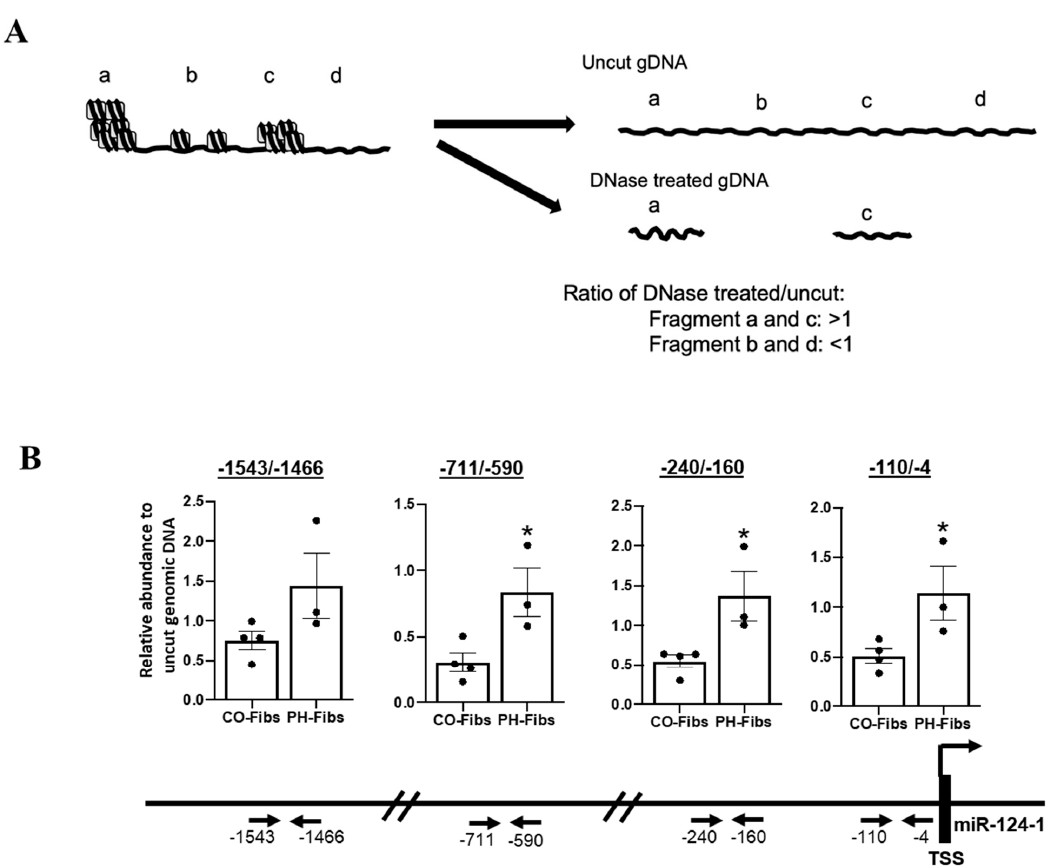
Figure 4. miR-124-1 gene in human PH-Fibs is more condensed (closed), compared to that in CO-Fibs, as assessed using DNase I sensitivity assay. ( A ) Schematic presentation of DNase I Sensitivity Assay. DNA in closed chromatin (a and c) is not accessible, thus resistant to DNase I digestion, so the ratios of these DNA in DNase treated genomic DNA pool versus in uncut genomic DNA pool will be close to 1 or above 1. However, DNA in more loosely packed chromatin (b and d) will be digested by DNase I, so the ratios of these DNA in DNase treated genomic DNA pool versus in uncut genomic DNA pool will be less than 1. ( B ) DNase I Sensitivity Assay was used to determine the chromatin structure of the miR-124-1 gene’s promoter (-110/-4), proximal promoter (-240/-160) and enhancers (-711/-590 and -1543/-1466) in CO- ( n = 4) and PH-Fibs ( n = 3). Data are presented as mean ±S.E.M, * p < 0.05 PH-Fibs vs. CO-Fibs.